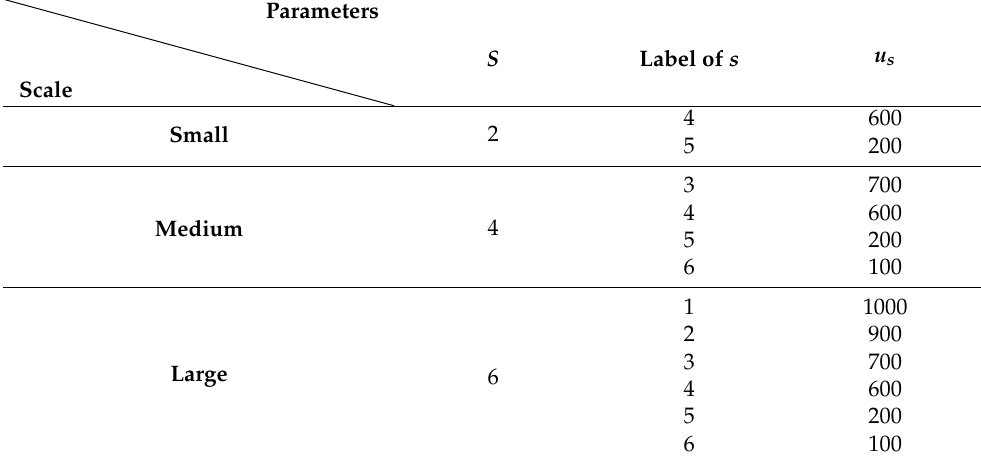
Table A2. Parameter settings related to s. “ S ” represents the types of feeders. For example, there are 2 types of feeders in the small scale. The corresponding ship numbers are 4 and 5, that is, the capacity of feeders 4 and 5 are 600 TEUs and 200 TEUs,